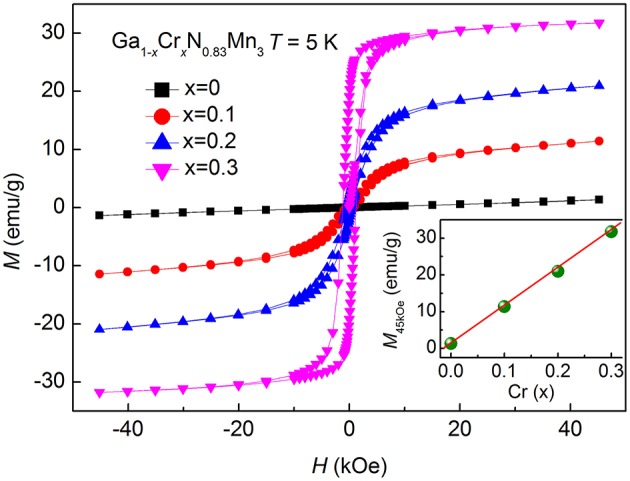
The isothermal magnetization M(H) loops at 5K for Ga1−xCrxN0.83Mn3 (x = 0, 0.1, 0.2, 0.3) measured between −45 and 45 kOe. Inset shows the magnetization at 45 kOe, M45kOe, as a function of Cr content (x).